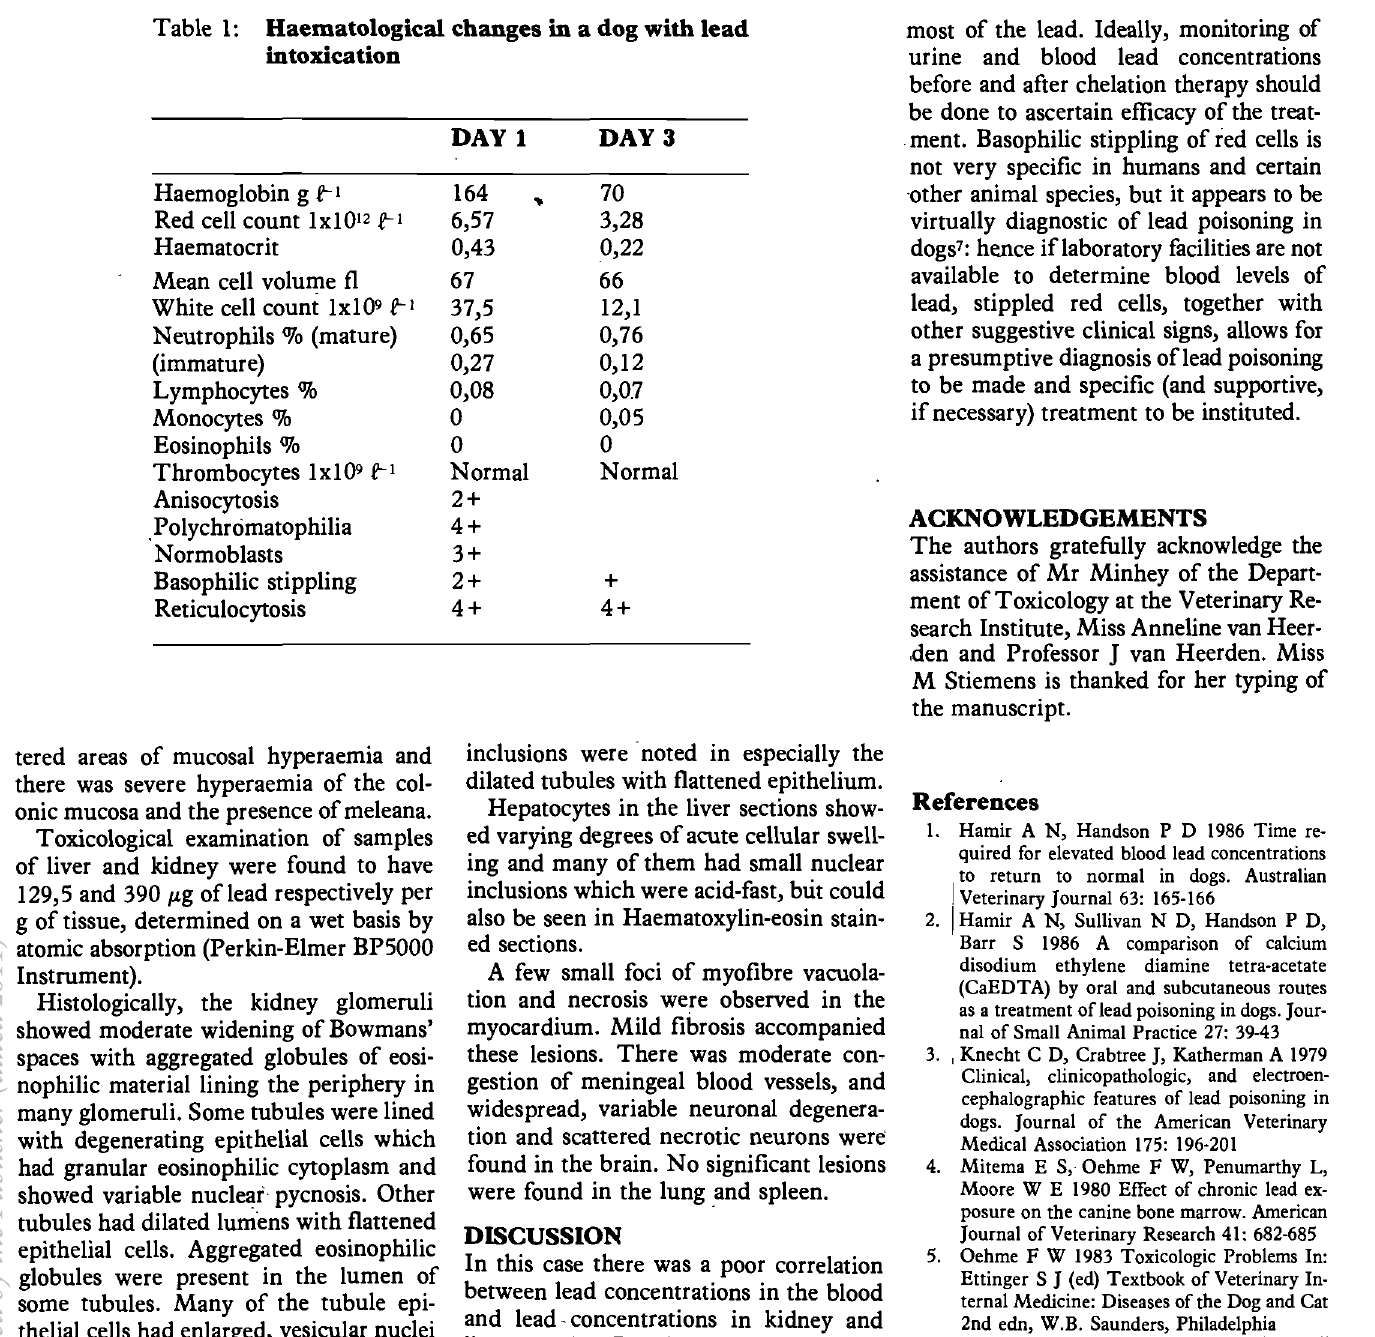
Haematological changes in a dog with lead